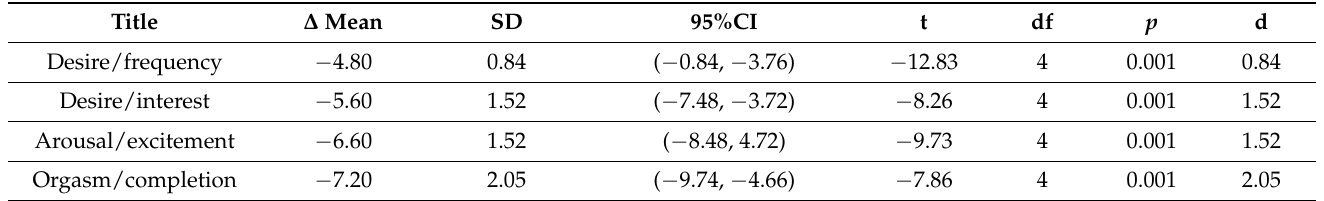
Table 1. Significance of the differences between the first and the last visit in CSFQ subscales.